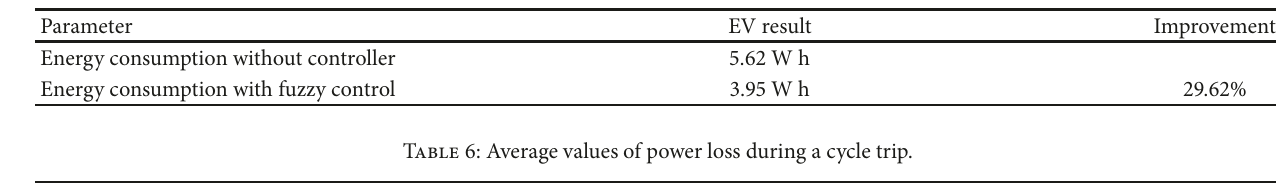
Table 5: Average values of energy consumption during a cycle trip.